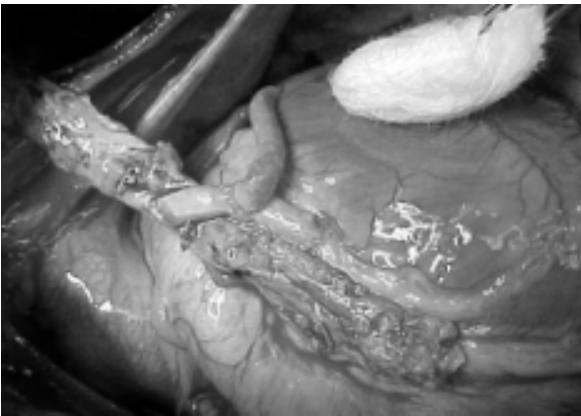
Fig. 2 - Enxerto composto, formado pela ATIE anastomosada na artéria DA, segmento de VSM originando-se da ATIE para 1 a diagonal, e um segundo segmento de VSM oriundo do primeiro segmento venoso para a 2 a marginal da artéria